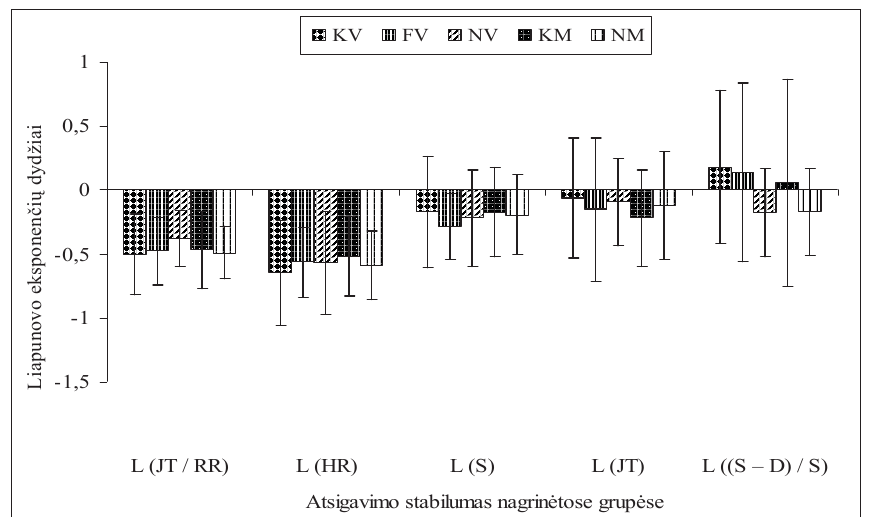
nul į ), o krepšinink ų ir futbolinink ų —